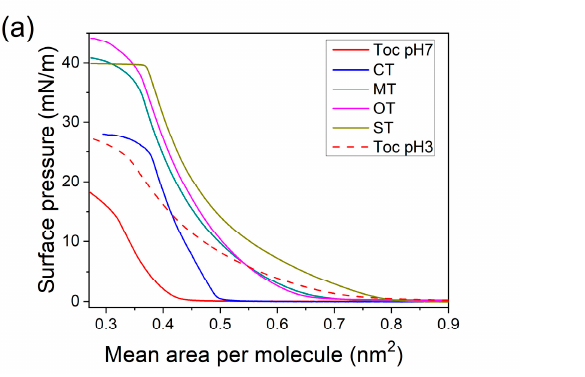
Figure 2. Surface pressure — area ( π -A) ( a ) and compressibility modulus–surface pressure (K- π ) ( b ) isotherms for Toc, CT, and esters (OT, MT, and ST). A CT isotherm is located between esters and Toc with π c at 27 mN/m which occurs at 0.39 nm 2 with further plateau. The small value of A 1 , π c , and shape of CT isotherm indicates that the molecule, during its interaction with subphase, has a tendency to stay in a less ordered gas phase than